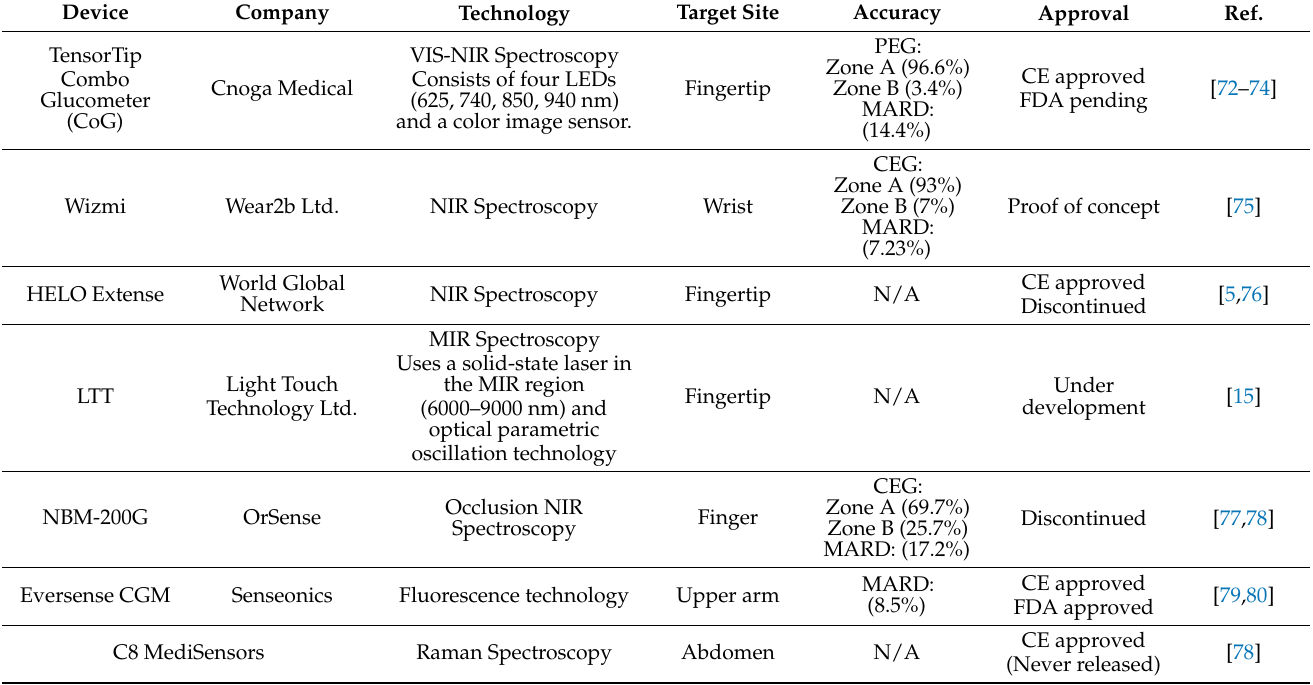
Table 5. Summary of the commercial devices that are based on the reviewed non-invasive glucose sensing techniques. Device